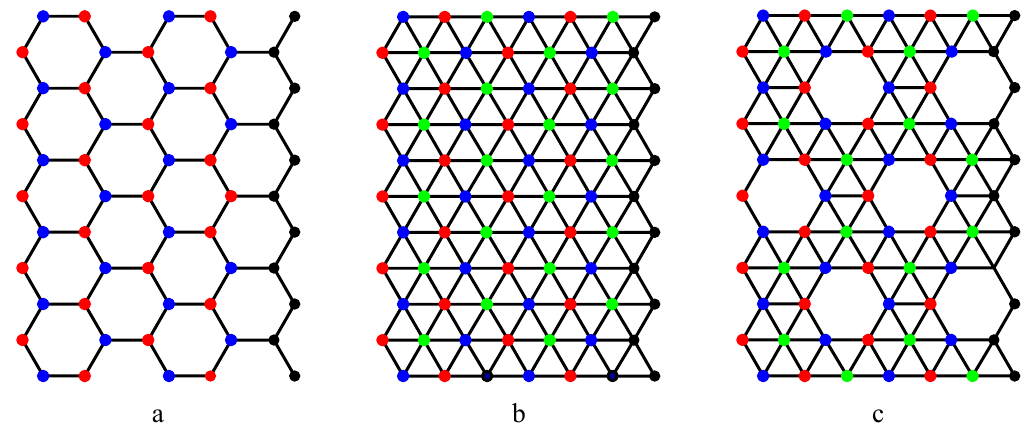
Figure 4. The maximum independent set is the same for all the three nanotubes. The set of red vertices is a maximum independent set of three nanotubes. The set of blue vertices is another maximum independent